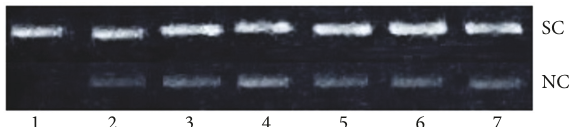
Figure 6: Changes in the agarose gel electrophoresis pattern of pBR322 plasmid DNA through hydrolytic cleavage: (1) DNA alone; (2, 3, 4) DNA + Cu(II) complex (15, 30, and 45 𝜇 M); (5, 6, 7) DNA + Ni(II) complex (15, 30, and 45 𝜇 M).